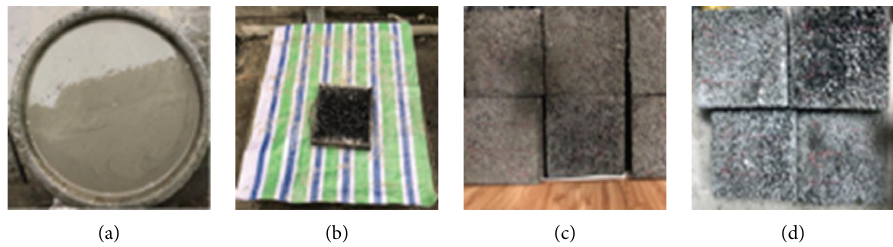
Figure 2: Grouting and formation of specimens. (a) Prepared cement slurry. (b) Grouting on the vibrating table. (c) Rutting specimens after grouting. (d) Rutting specimens after